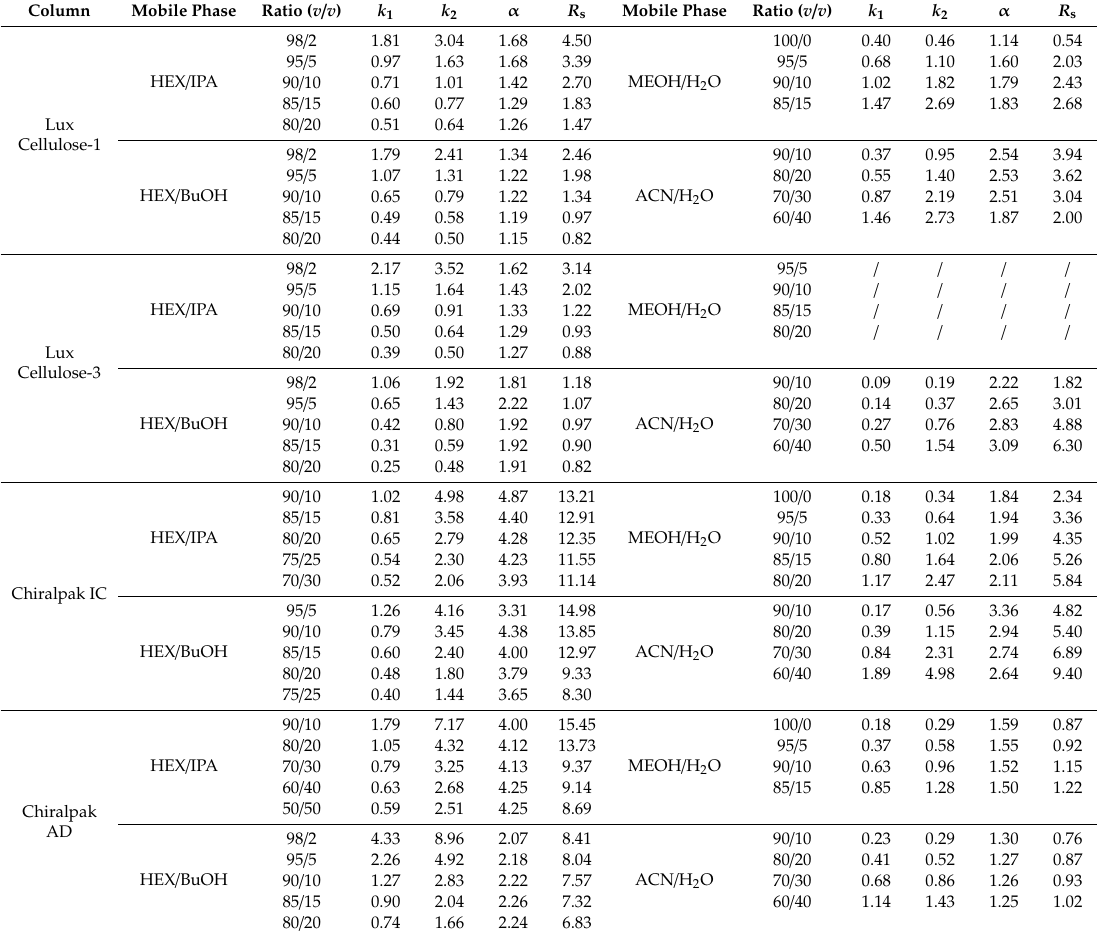
Table 1. Enantiomeric separation of etoxazole enantiomers on four chiral columns.